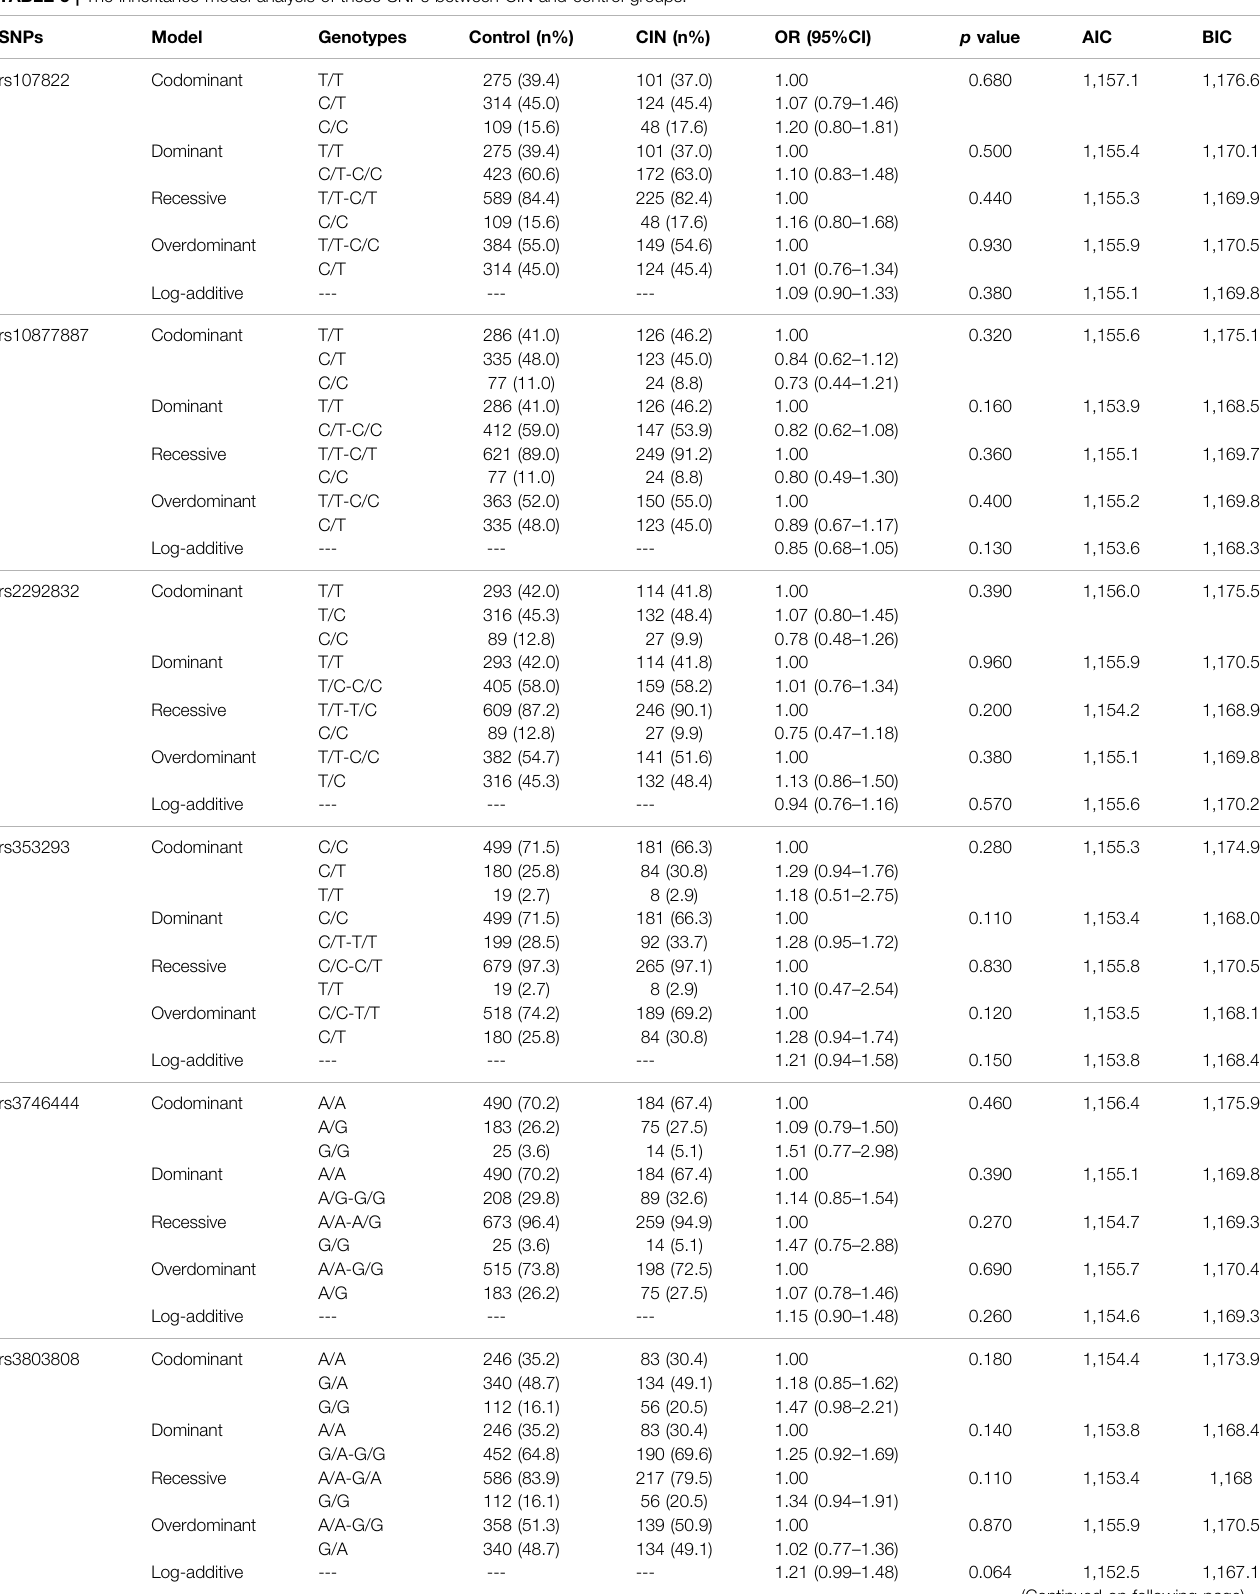
TABLE 5 | The inheritance model analysis of these SNPs between CIN and control